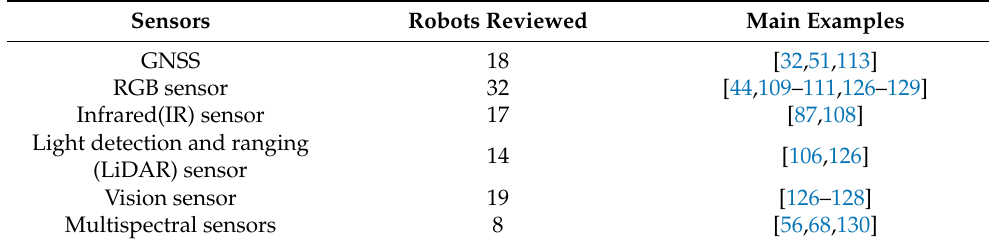
Table 4. Sensors used by agricultural robots.